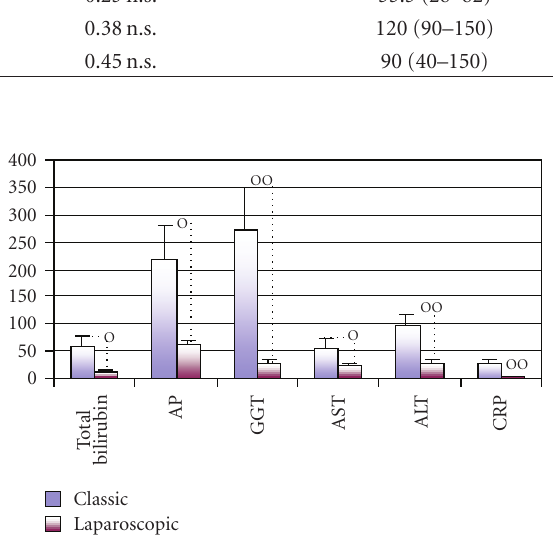
Figure 1: Preoperative values of total bilirubin, enzyme tests (alka- line phosphatase-AP, gamma-glutamyl transferase-GGT, aspar- tat aminotransferase-AST, alanine aminotransferase-ALT and C- reactive protein-CRP in sera of patients chosen for classic or laparoscopic cholecystectomy. o P < . 05, oo P < .